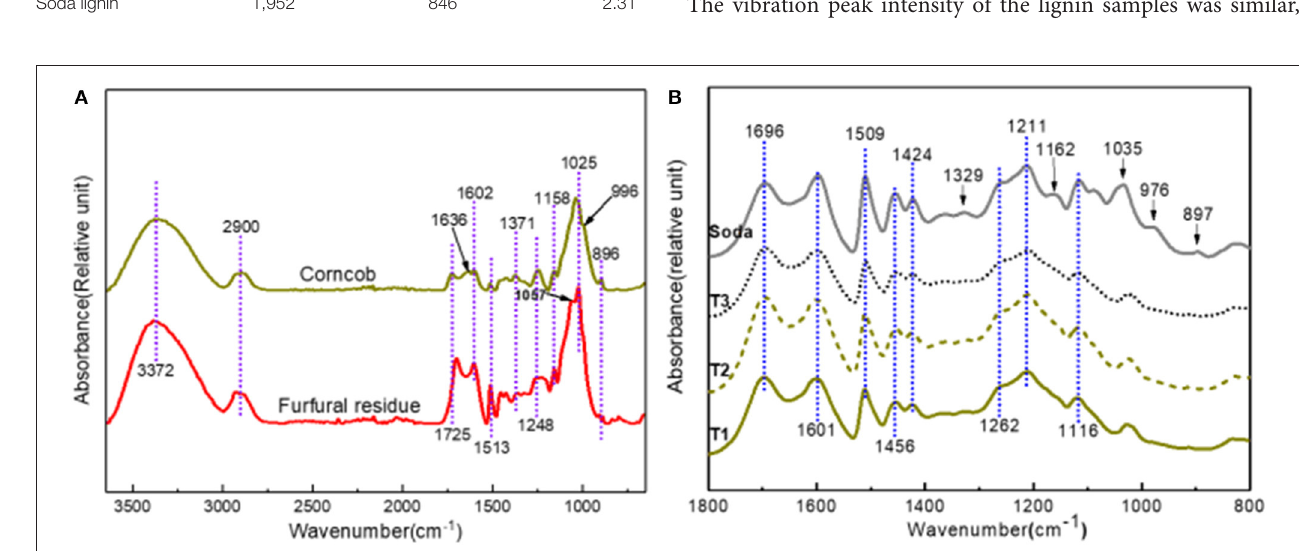
FIGURE 1 | ATR spectra of corncob, furfural residue (A) and extracted lignin samples (B) .